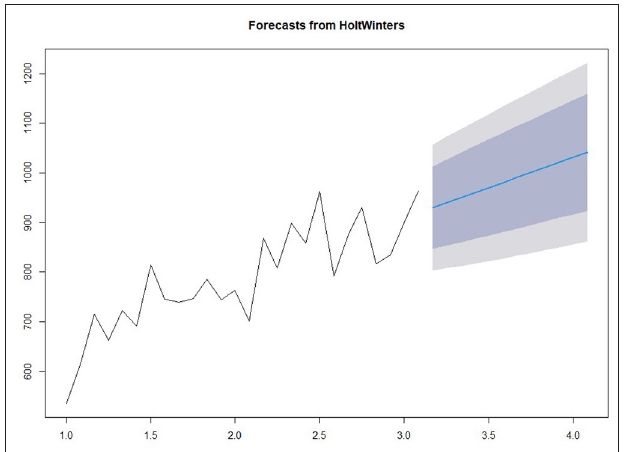
FIGURE 4 | Autocorrelation.